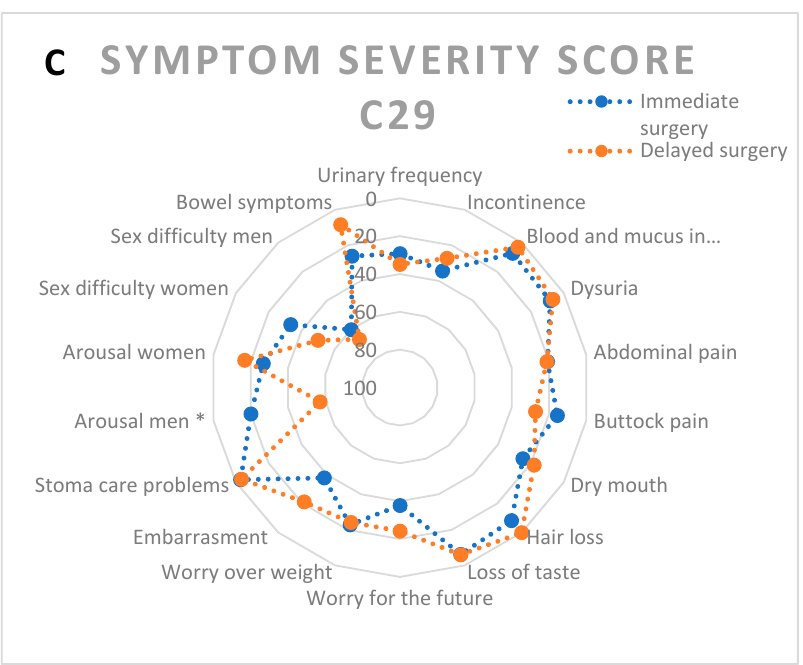
Figure 2. Radar charts depicting quality of life for immediate vs. delayed surgery groups. Means are given. * signifies statistical significance at p < 0.05. ( A ) Functional scores and QoL item. ( B ) QLQ-C30 symptom scores. ( C ) QLQ-CR29 symptom scores.